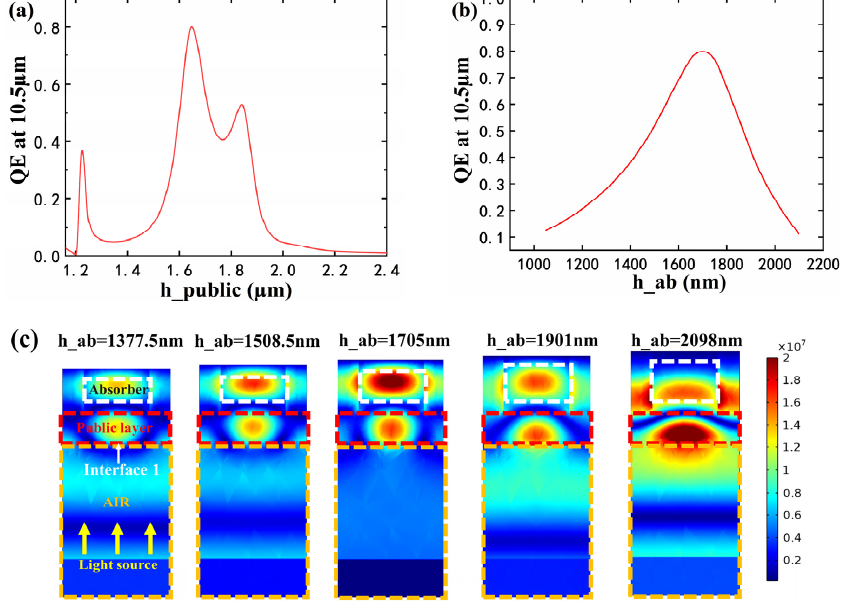
Figure 6. ( a ) QE at 10.5 µ m as a function of h_public. ( b ) QE at 10.5 µ m as a function of h_ab. ( c ) |E x | distribution in XZ cross-sections of the device at h_ab = 1377.5 nm, 1508.5 nm, 1705 nm, 1901 nm, and 2098 nm in Figure